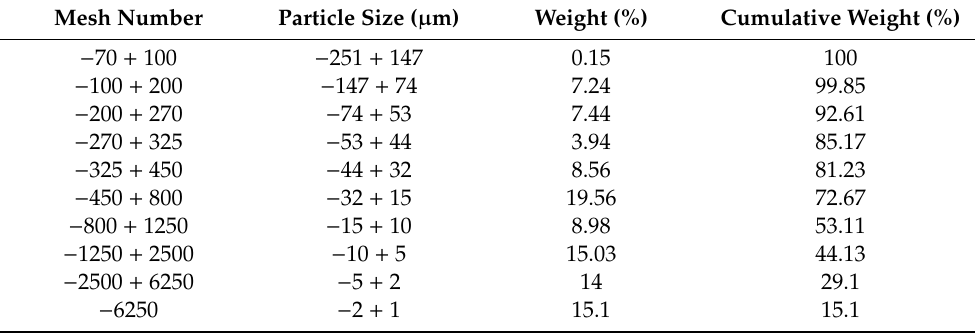
Table 2. Particle size composition of coal